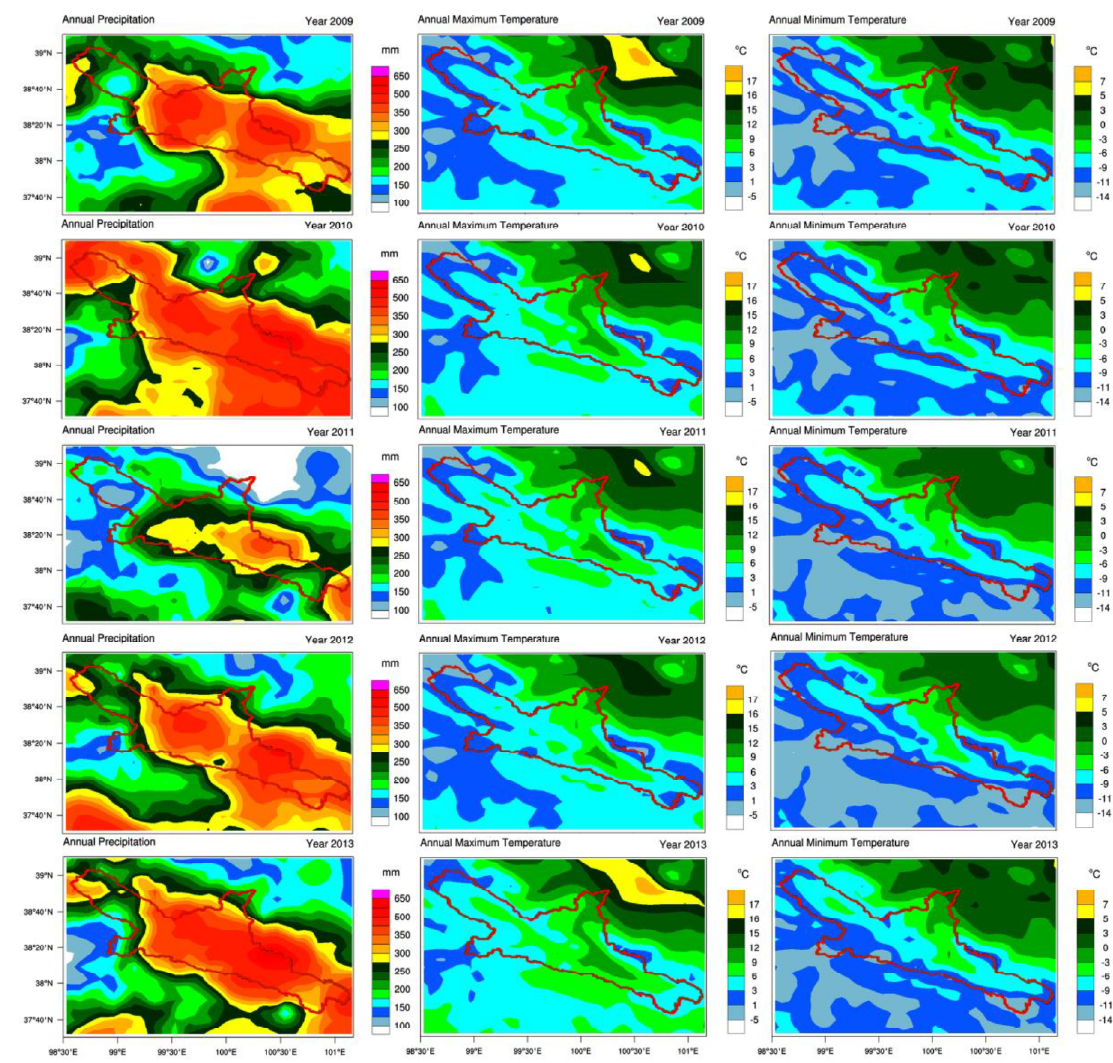
Figure 3. This study emphasizes verifying the utility of the CMADS dataset for driving hydrological model in China. Water 2019 , 11 , x FOR PEER REVIEW